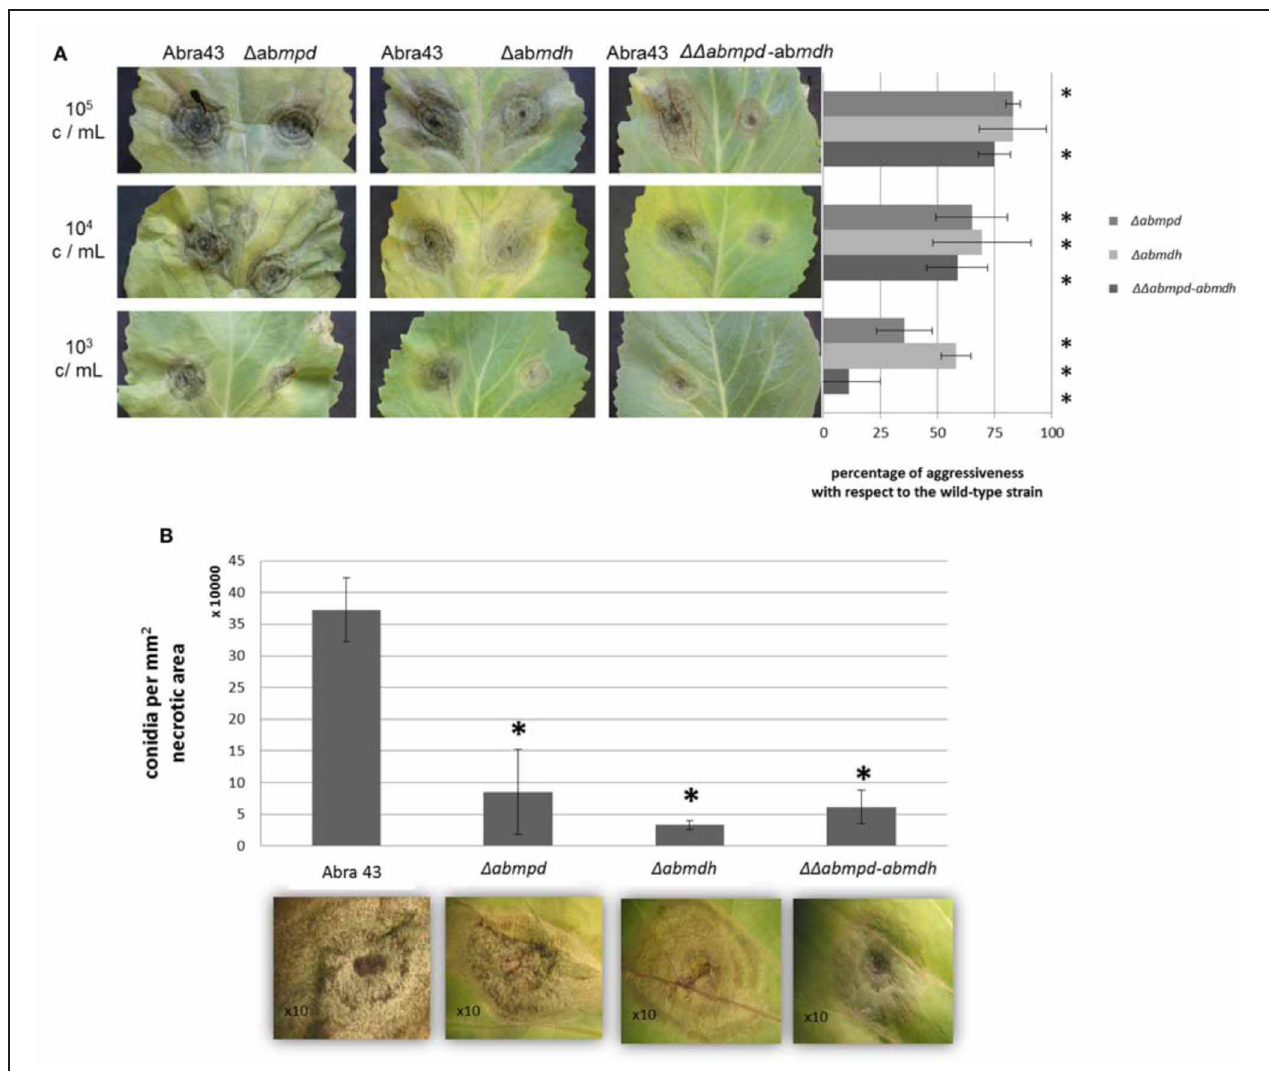
wild-type aggressiveness (100%) using the Student test ( P < 0 . 01). (B) Effects of mutations in mannitol metabolism genes on the quantity of conidia produced in planta . The number of conidia is expressed per mm 2 of necrotic B. oleracea leaf tissue at 6dpi. For each genotype, five lesions were sampled and vortexed for 30s in water containing Tween 20 (0.02%, v/v). The concentration of the resulting conidia suspensions was estimated microscopically using a haemocytometer. Error bars indicate standard deviations and asterisks indicate a significant difference with respect to the wild-type using the Student test ( P < 0 .